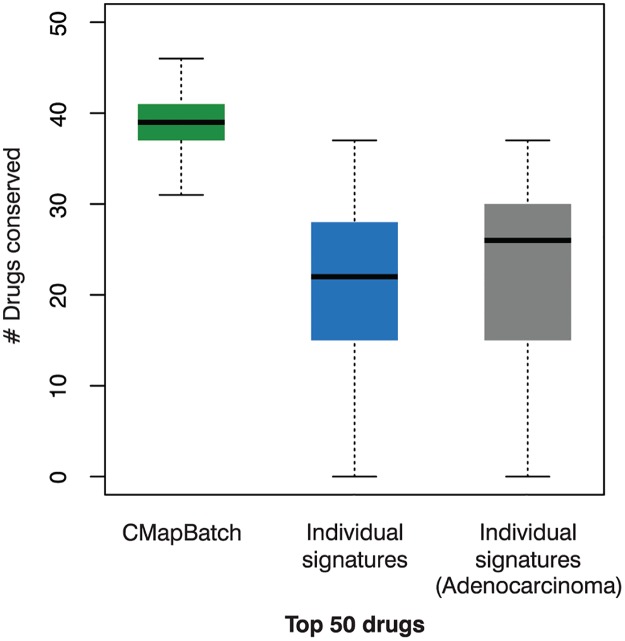
CMapBatch produces more stable lists of significant drugs than individual gene signatures.Shown are boxplots of the number of conserved drug candidates when any two lists of top 50 drug candidates are intersected. Green: 21 gene signatures were split into two disjoint sets of 10 and 11 signatures, CMapBatch was run on both sets, and top drugs from each set were compared; this experiment was repeated 100 times. Blue: 21 gene signatures were used to retrieve 21 lists of drugs with the CMap online tool; top drugs from all pairs of signatures were compared. Grey: 10 gene signatures of the same lung cancer type (adenocarcinoma) were used to retrieve 10 lists of drugs with the CMap online tool; top drugs from all pairs of signatures were compared. CMapBatch results showed a significantly higher median overlap (Wilcox test P << 0.01).